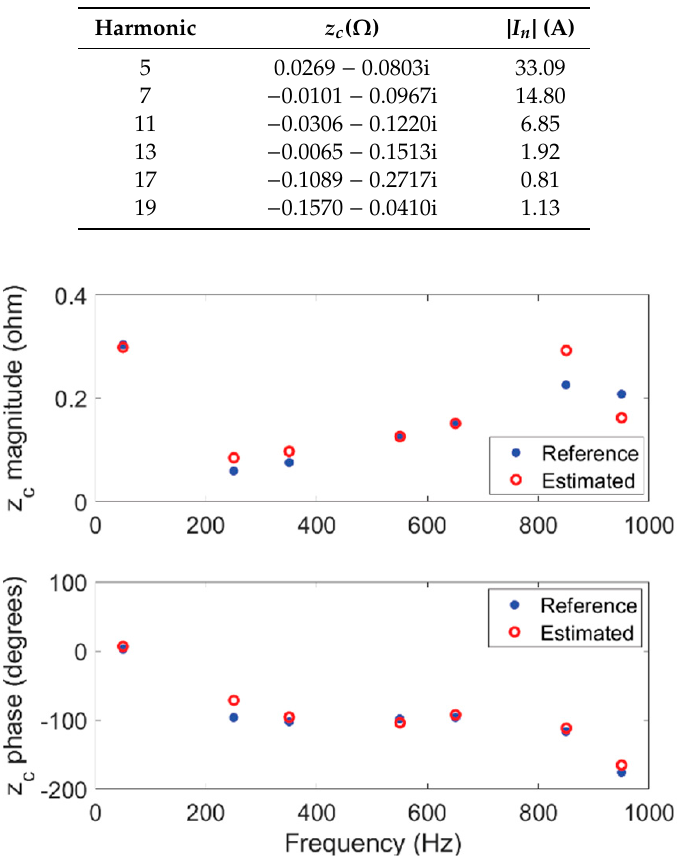
Table 3. Customer side impedance and magnitude of Norton’s current injection calculated using transformer switching event at time t = 21 s.